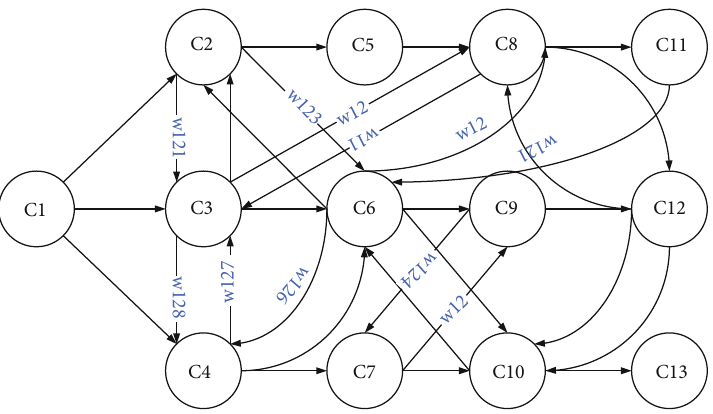
Figure 1: Fuzzy weighted directed